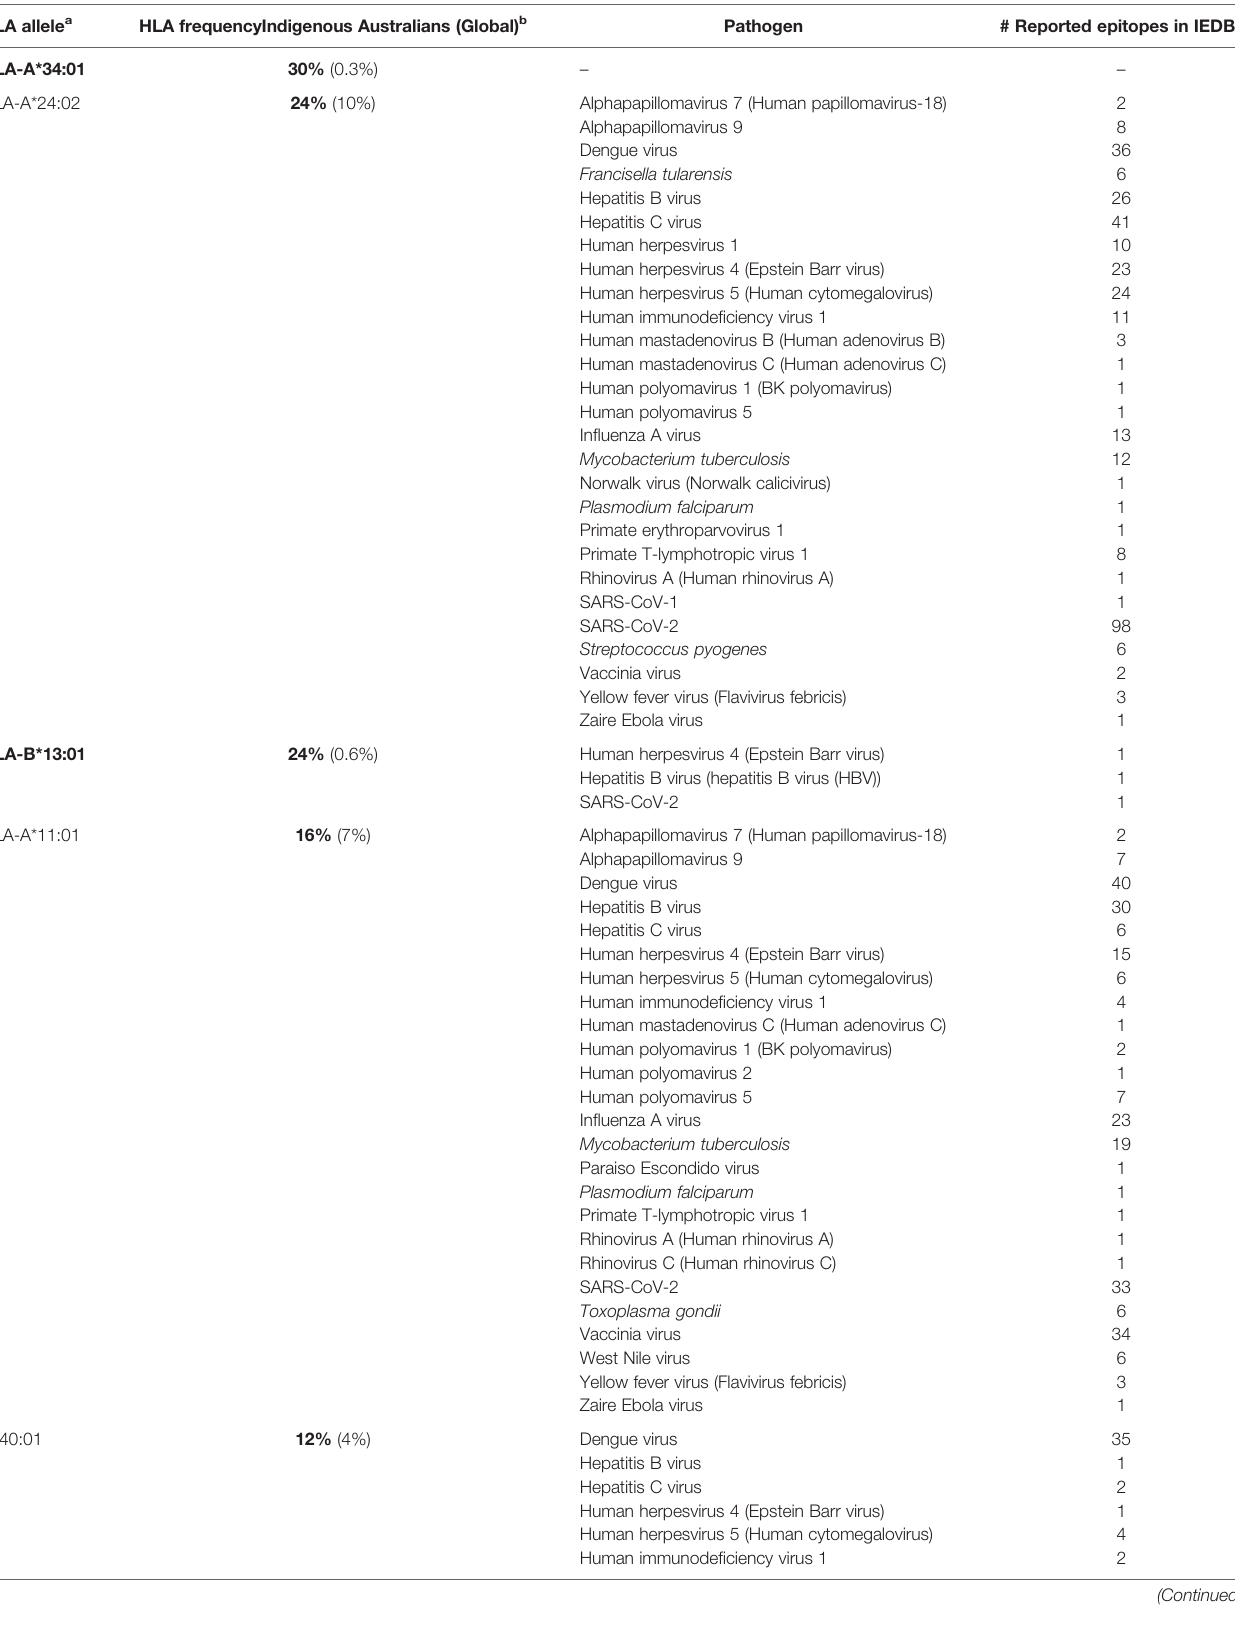
TABLE 1 | Indigenous Australian HLA alleles are underrepresented in T cell epitope